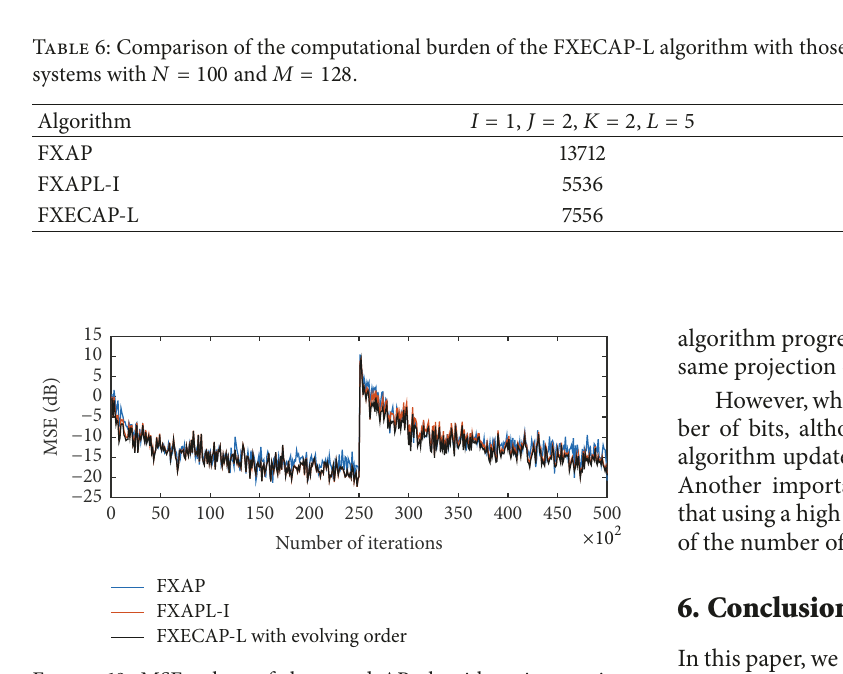
Figure 19: MSE values of the tested AP algorithms in a variant multichannel system. The projection order used is 𝐿 = 5 and 𝑏 = 8 bits are used to encode the error.